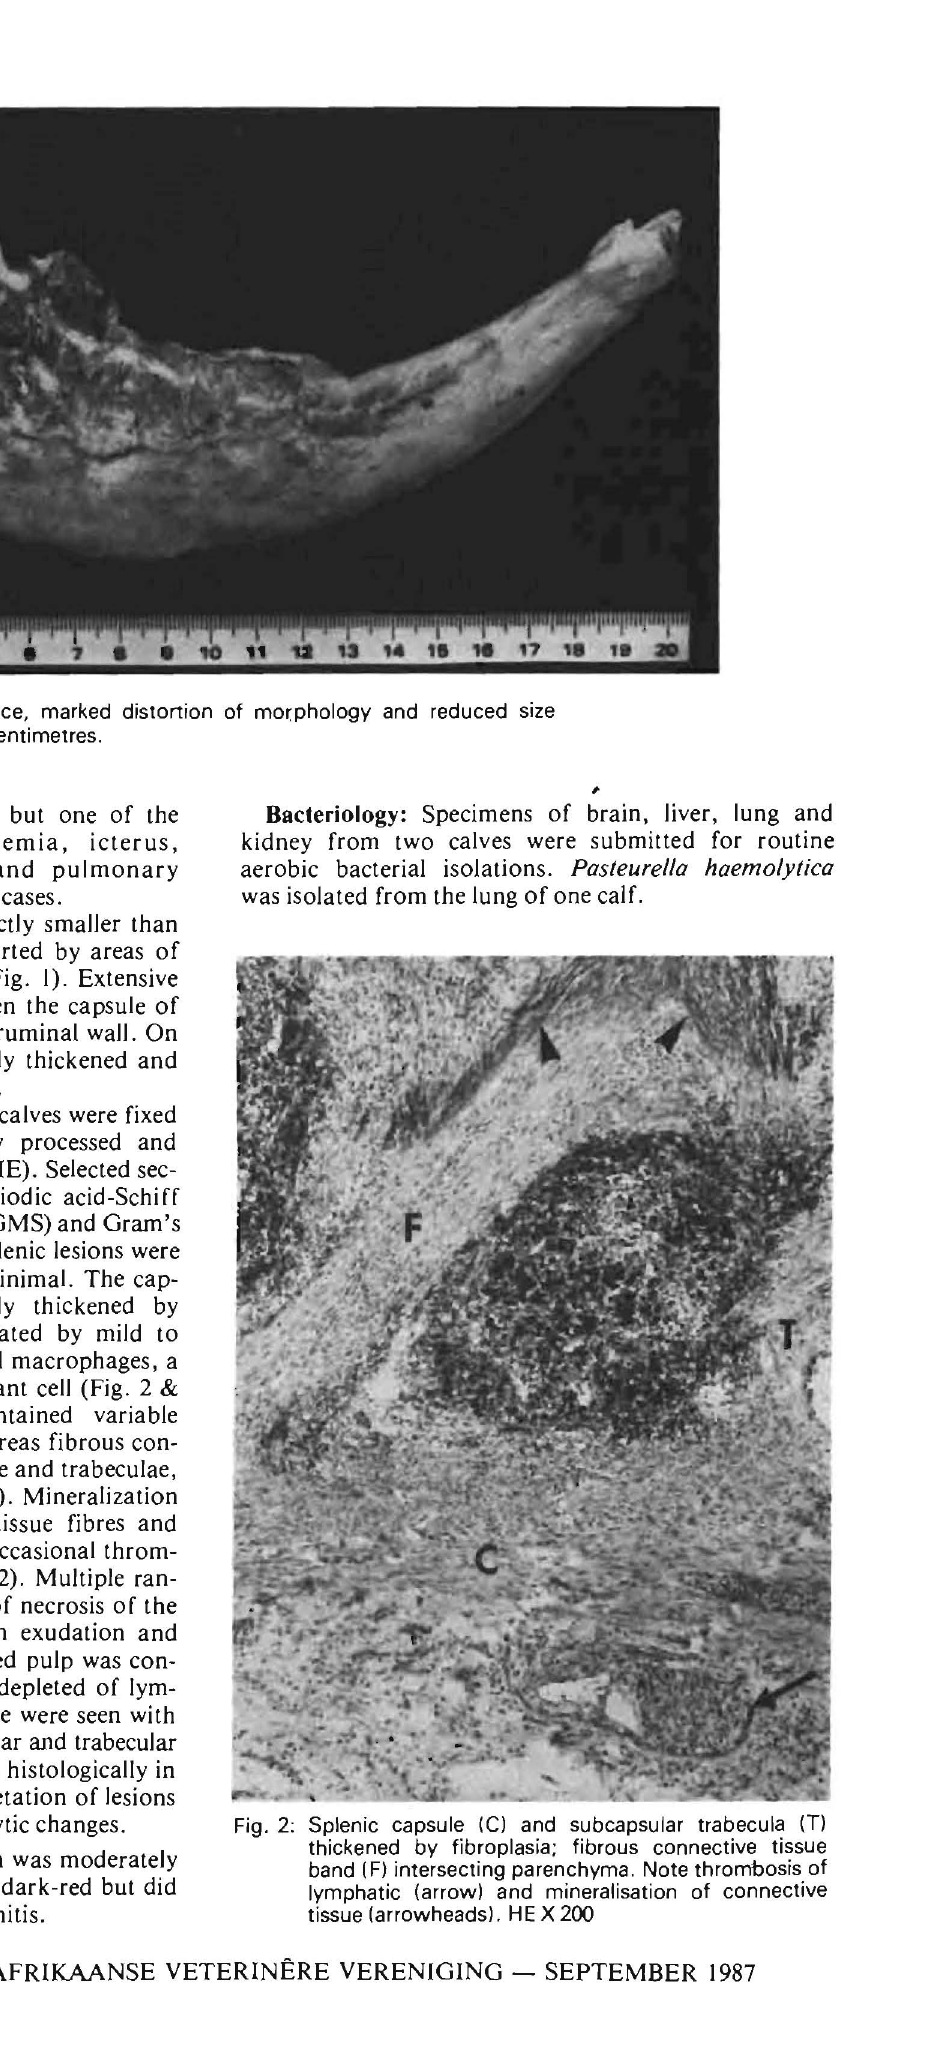
TYDSKRIF VAN DIE SUID-AFRIKAANSE VETERINERE VERENIGING